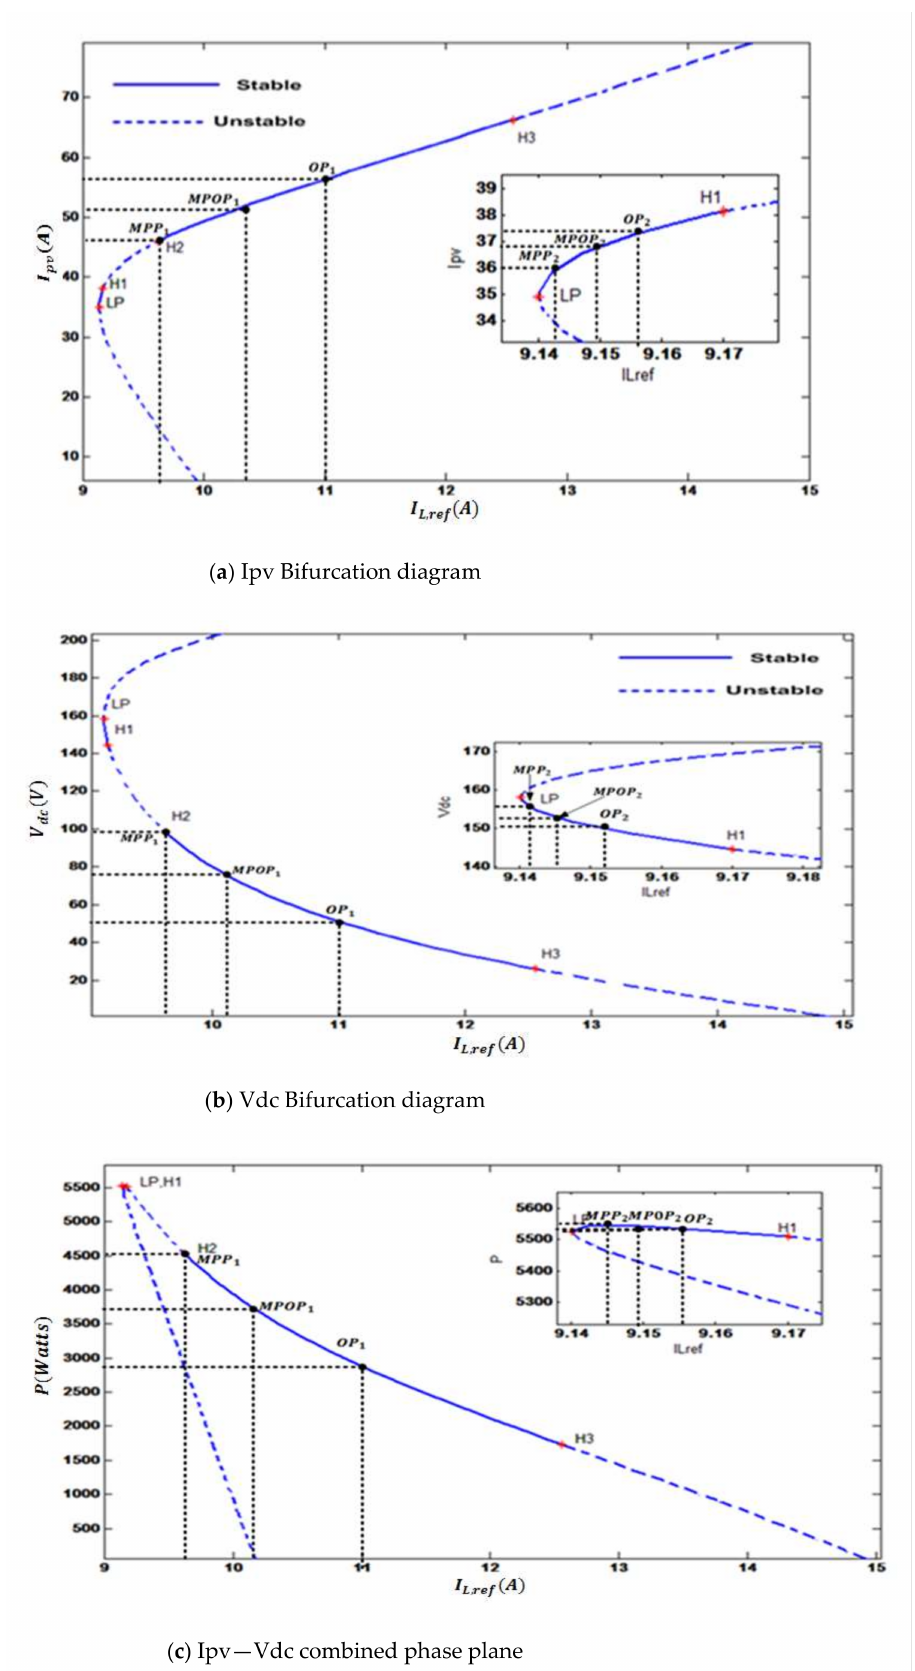
Figure 7. Bifurcation diagrams at G = 200, T = 25 ◦